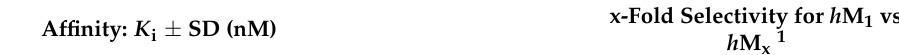
Table 3. Inhibition of [ 3 H]NMS binding in CHO- h M 1-5 cell membrane preparations and subtype selectivity